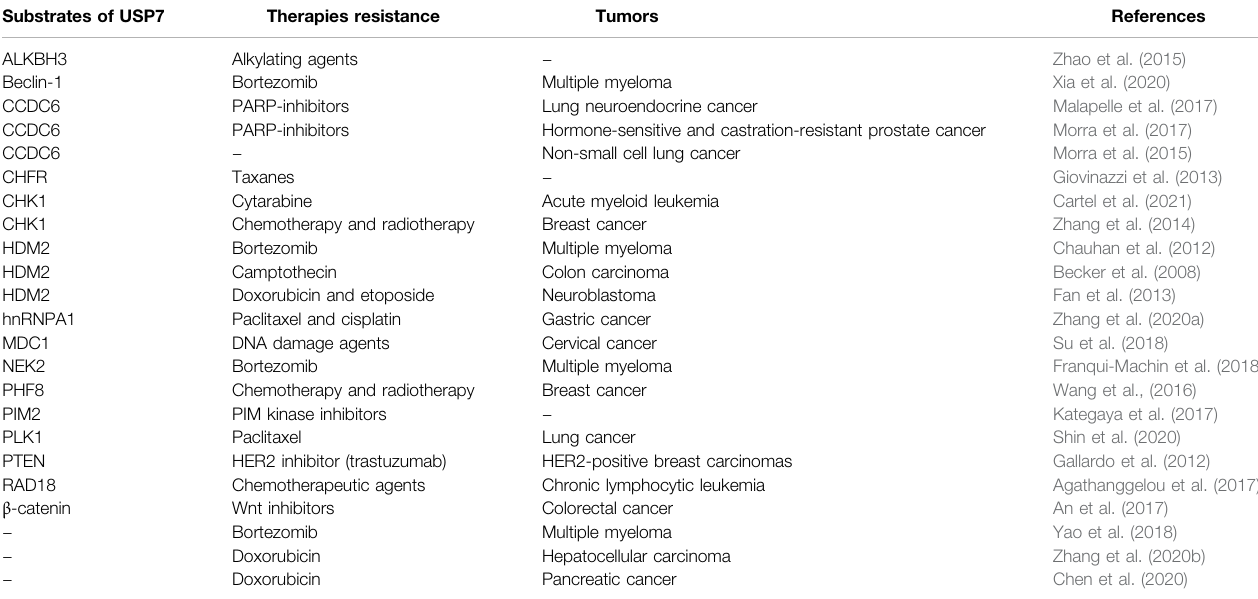
TABLE 1 | Substrates of USP7 involved in anti-tumor therapies resistance. Substrates of